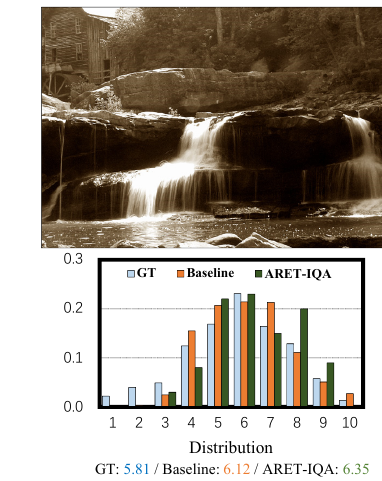
Figure 4. Example results of the proposed ARET-IQA (384) and the baseline model on the SPAQ [27] and AVA [11] databases. The predicted quality scores (MOS or distribution) of the baseline and our ARET-IQA as well as the corresponding ground truth (GT) are shown below each image. In the AVA database, we also show the average scores of aesthetic distribution.